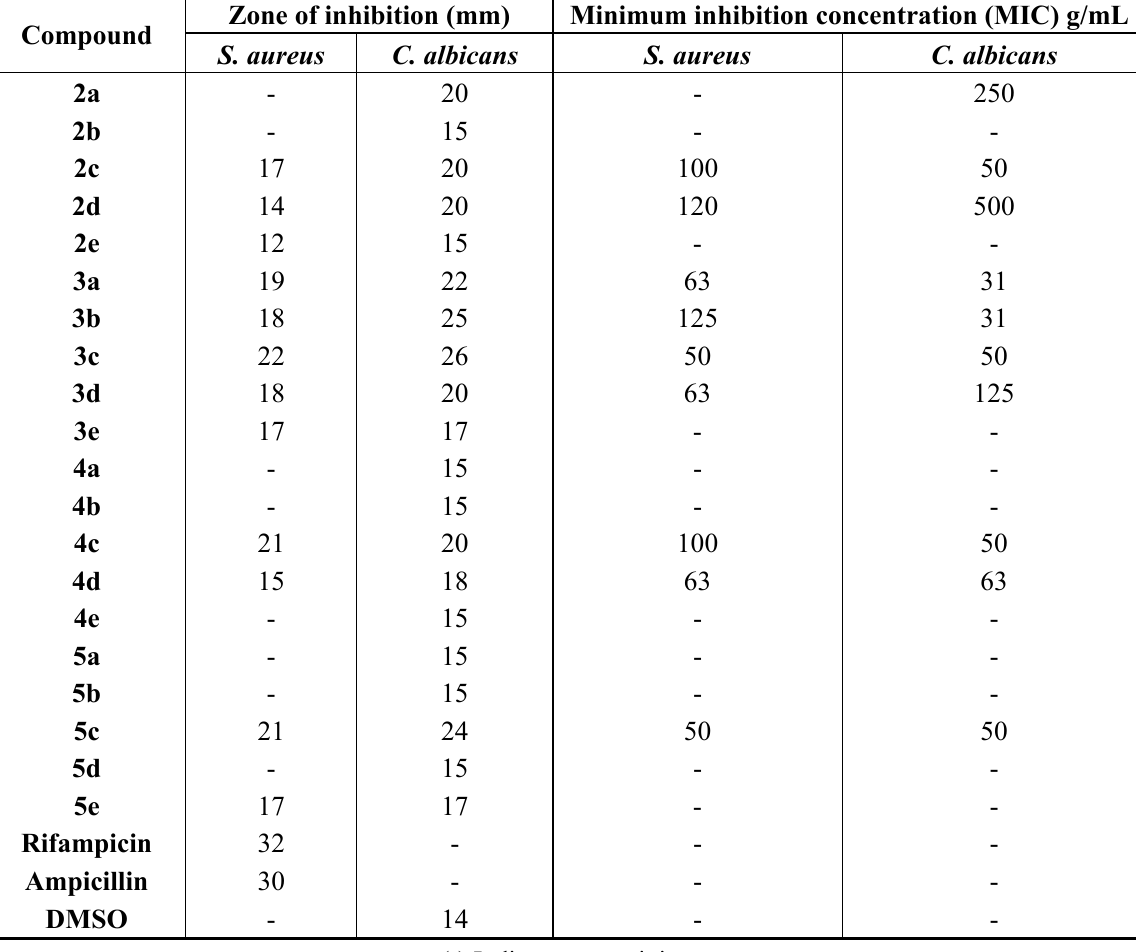
Table 3. Antimicrobial activities of all the synthesized